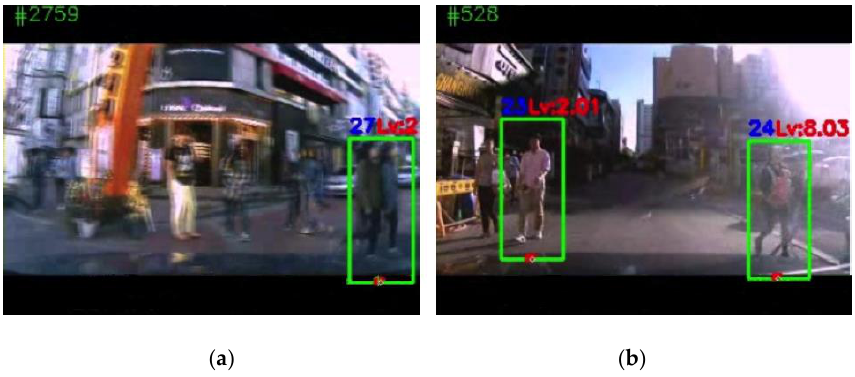
Figure 14. Two examples of failure of the proposed system: ( a ) Frame 2759 of the APT_S1 dataset. Due to the blurred image, many pedestrians were not detected. ( b ) Frame 526 of the APT_S1 dataset. Incorrect feature extraction and direction of movement for the right pedestrian led to an incorrect judgement. That is, she was quite safe actually, but got a high risk level.